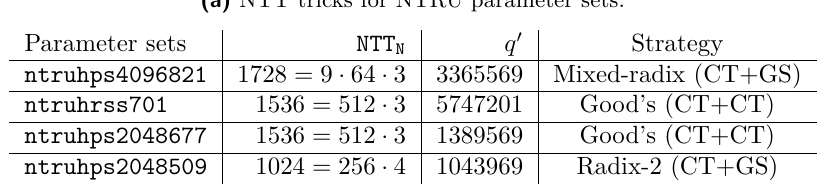
Table 3: Overview of NTTs for NTRU on Cortex-M4 (a) NTT tricks for NTRU parameter